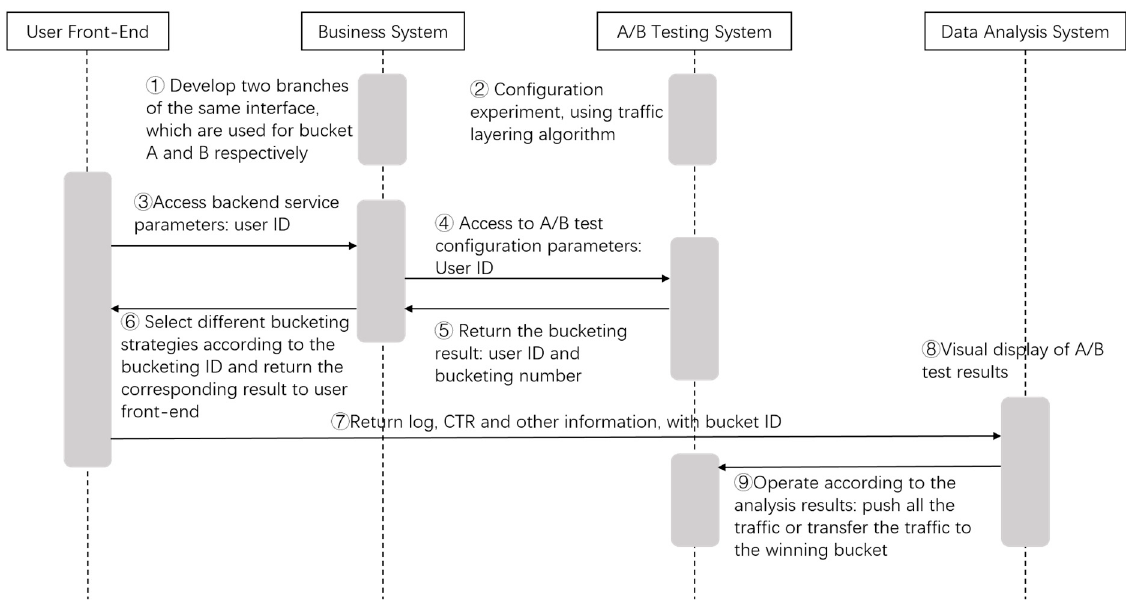
Figure 7. The business process of A/B Testing Service.